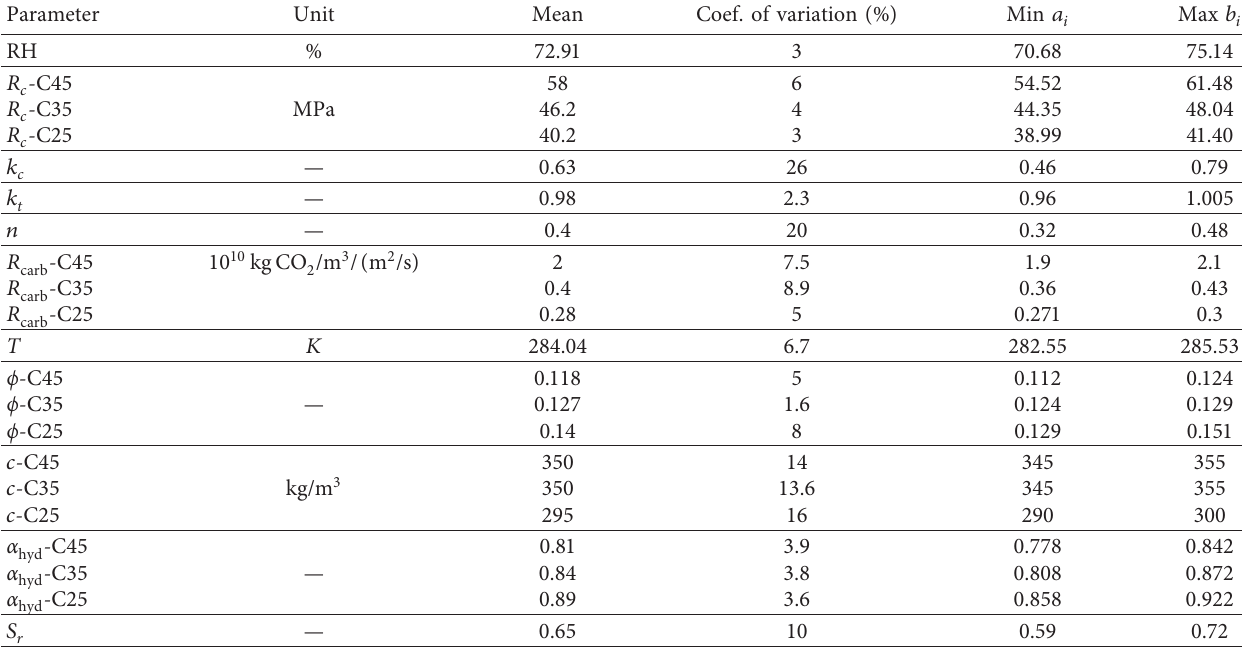
Table 9: Values of input parameters for carbonation models by Rakotovao Ravahatra et al.